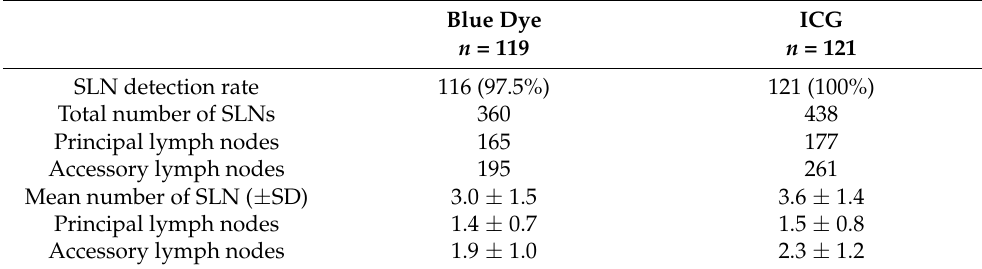
Table 2. Lymph node